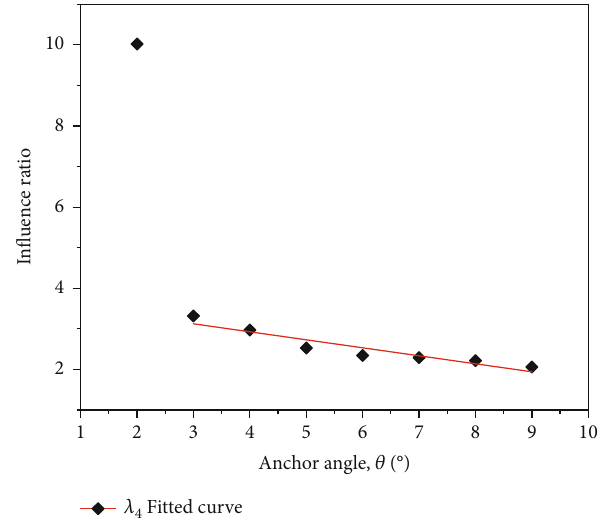
Figure 9: In fl uence ratio of the soil displacement as a function of anchor angle for D = 55 % and E / D = 3 r